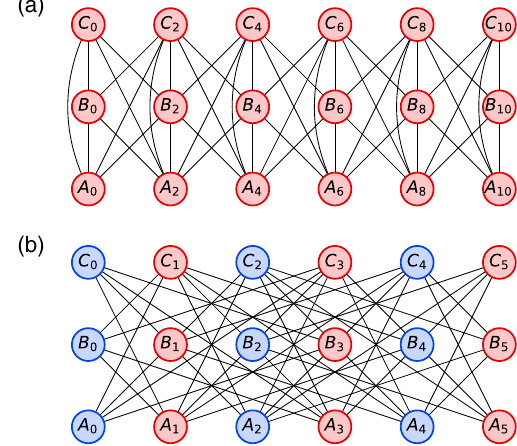
FIG. 8. Frustration graphs of the f A ¼ X ⊗ r ; B ¼ Y ⊗ r ; C ¼ Z ⊗ r g ensembles with (a) r ¼ 3 and (b) r ¼ 4 , for a finite system. Each vertex represents one operator; edges connect anticommut- ing operators. For odd r , the graph decomposes into two identical, disconnected subgraphs — (a) shows only one of them. For even r , the graph is connected but bipartite [as indicated by the color scheme in (b)], and there is no volume-law phase despite the higher connectivity of the